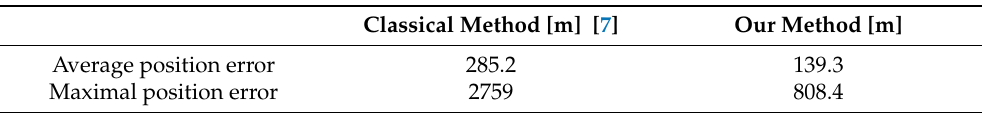
Table 2. Table with errors for two jammers transmitting Zadoff–Chu sequences. Our method, using neural network processing, is compared with the classical method for